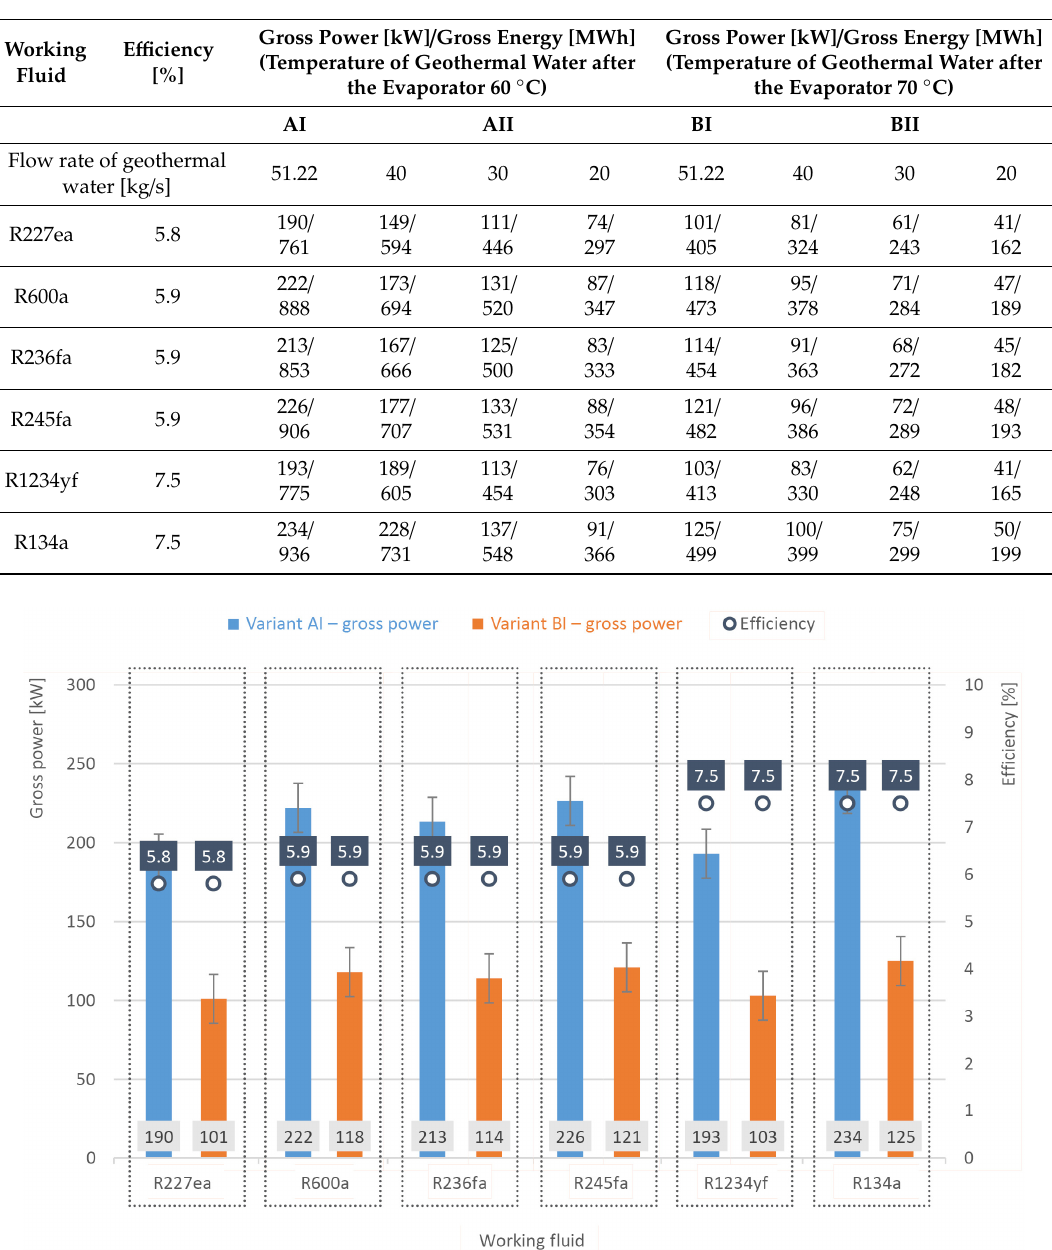
Table 2. Results of thermodynamic calculations for variants I and II with organic Rankine cycle (ORC) technology.